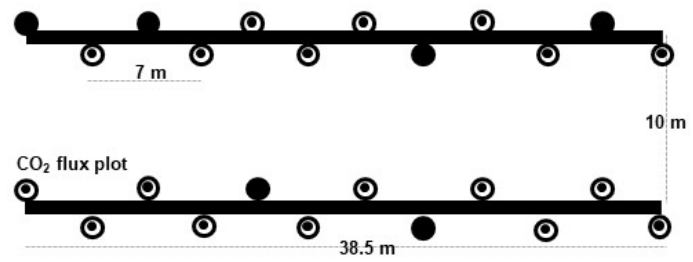
Figure 2. Plot design to measure CO 2 fluxes, soil total (hollow; 18) and heterotrophic (black; 6) respirations in two transects of 38.5 m undisturbed peat swamp forests (PSF; n = 3), partially logged peat forests (LPSF; n = 3), oil palm estate (OP; 3 plots) and early seral (ES; 3 plot)